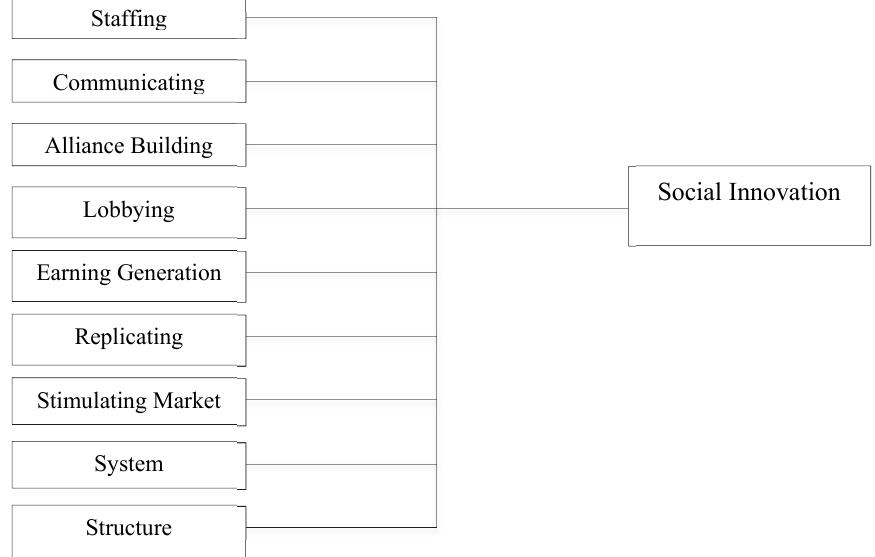
Fig. 1. Theoretical